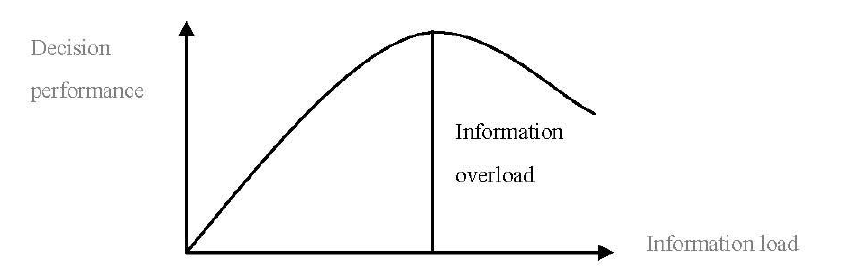
Figure 1. A conceptual representation of the well-known inverted u-curve [29]. Figure is adapted (modified and re-drawn) from Eppler and Mengis (2003)